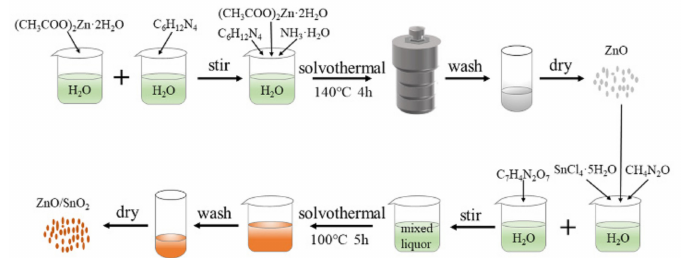
Figure 1. Preparation process of ZnO, SnO 2, and ZnO/SnO 2